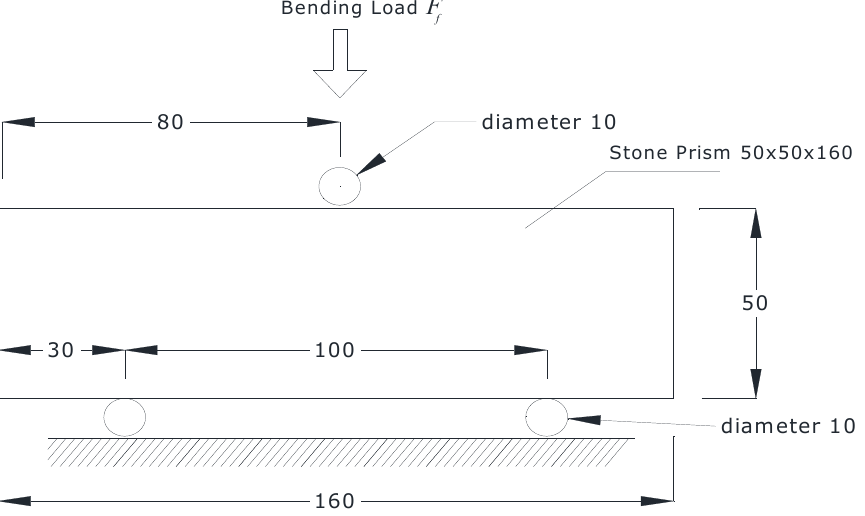
Figure 10. The schematic representation of the testing procedure (dimensions in mm).